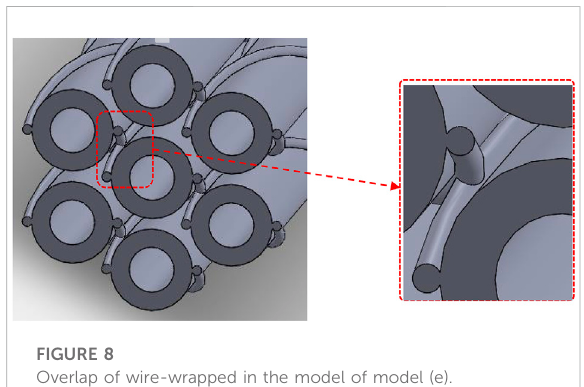
FIGURE 8 Overlap of wire-wrapped in the model of model